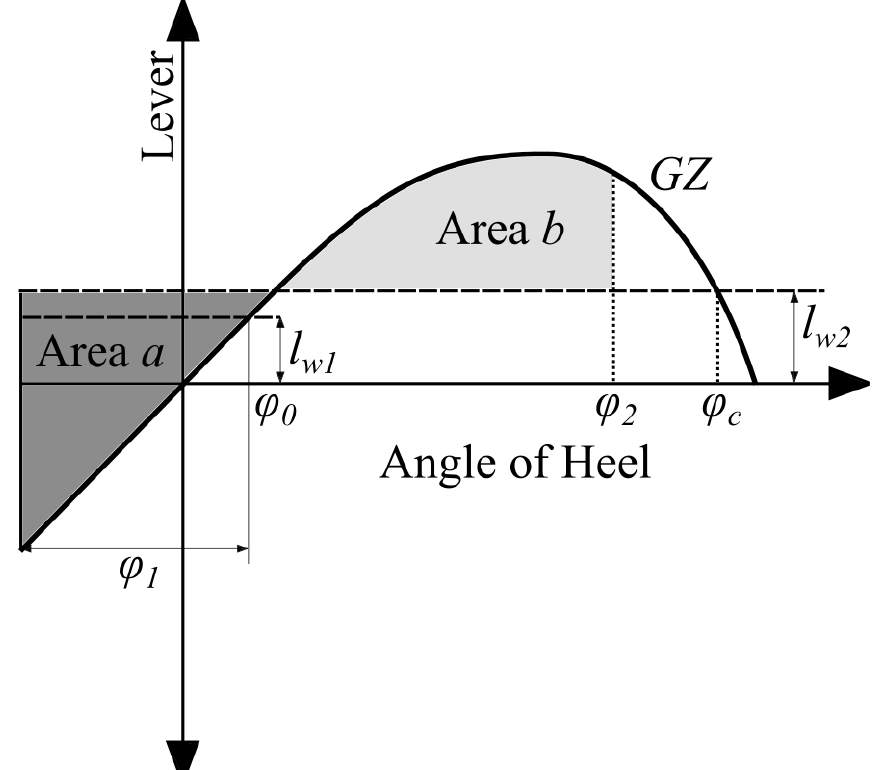
Figure 2. Dead ship level 1 righting arm area definitions.